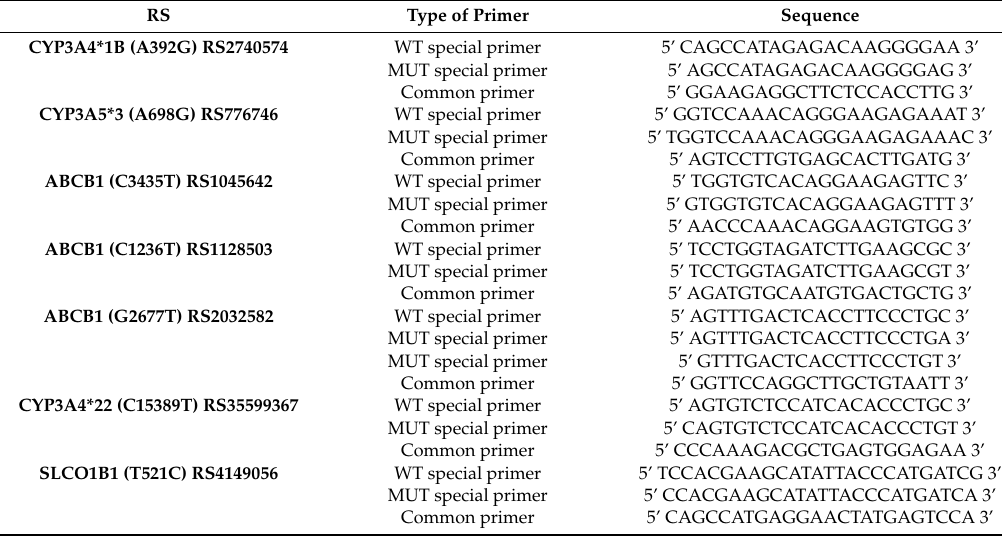
Table 5. Primers used for